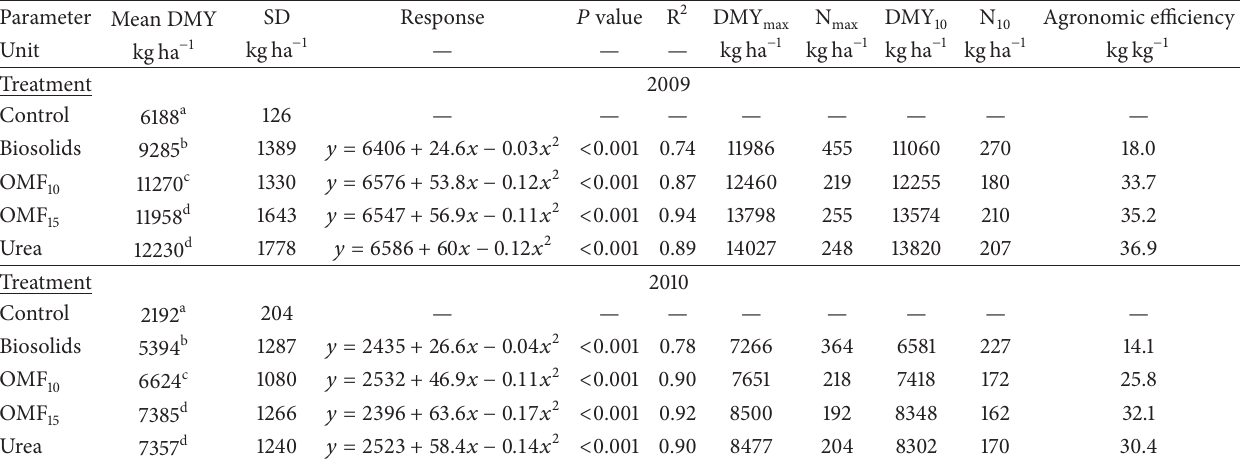
Table 1: Parameters derived from the response of the grass crop to the application of fertiliser-N in 2009 and 2010. Parameter Mean DMY